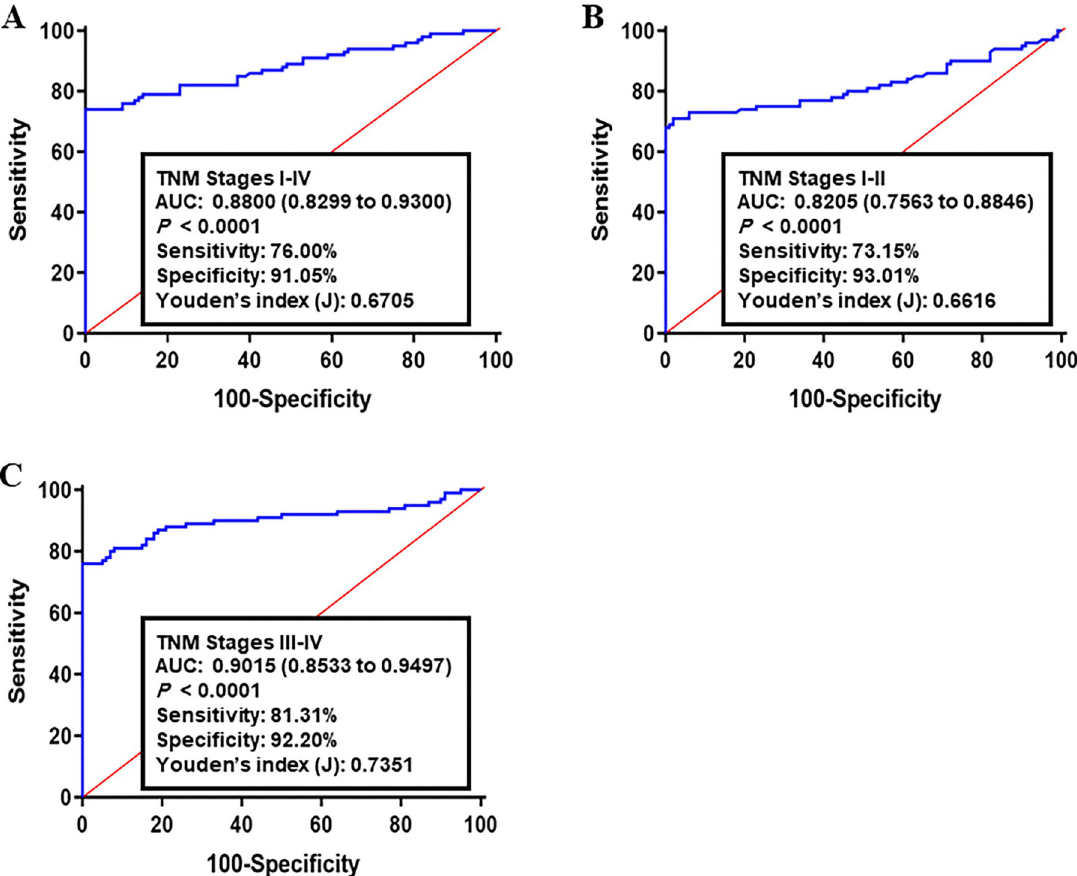
Fig 2. Receiver operating characteristics (ROC) curve analysis of the log it model with the ACOT8/ACSL5/FASN/HMGBCS2/ SCD1 panel in the validation set I. The study group consisted of 223 CRC tumor specimens and matched adjacent normal tissues. Using the optimal cutoff value as 0.493, the diagnostic performance of gene panel for discriminating (A) All TNM stages, (B) early CRC (I-II TNM stages), and (C) advanced CRC (III-IV TNM stages) from healthy samples was examined. Log it (p) of model was 0.429 + 0.659 x ACOT8 + 0.084 x ACSL5 + 0.029 x FASN + 0.201 x HMGCS2 + 0.119 x